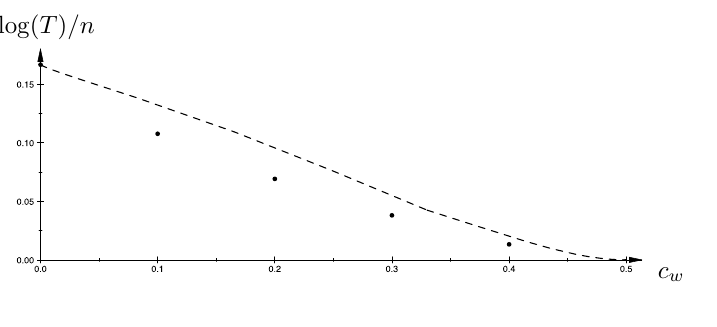
Figure 8: Run-time exponent log( T ) of the approximate 32-list algorithm for minimal time n (dots) and given by Theorem 4 (curve)).